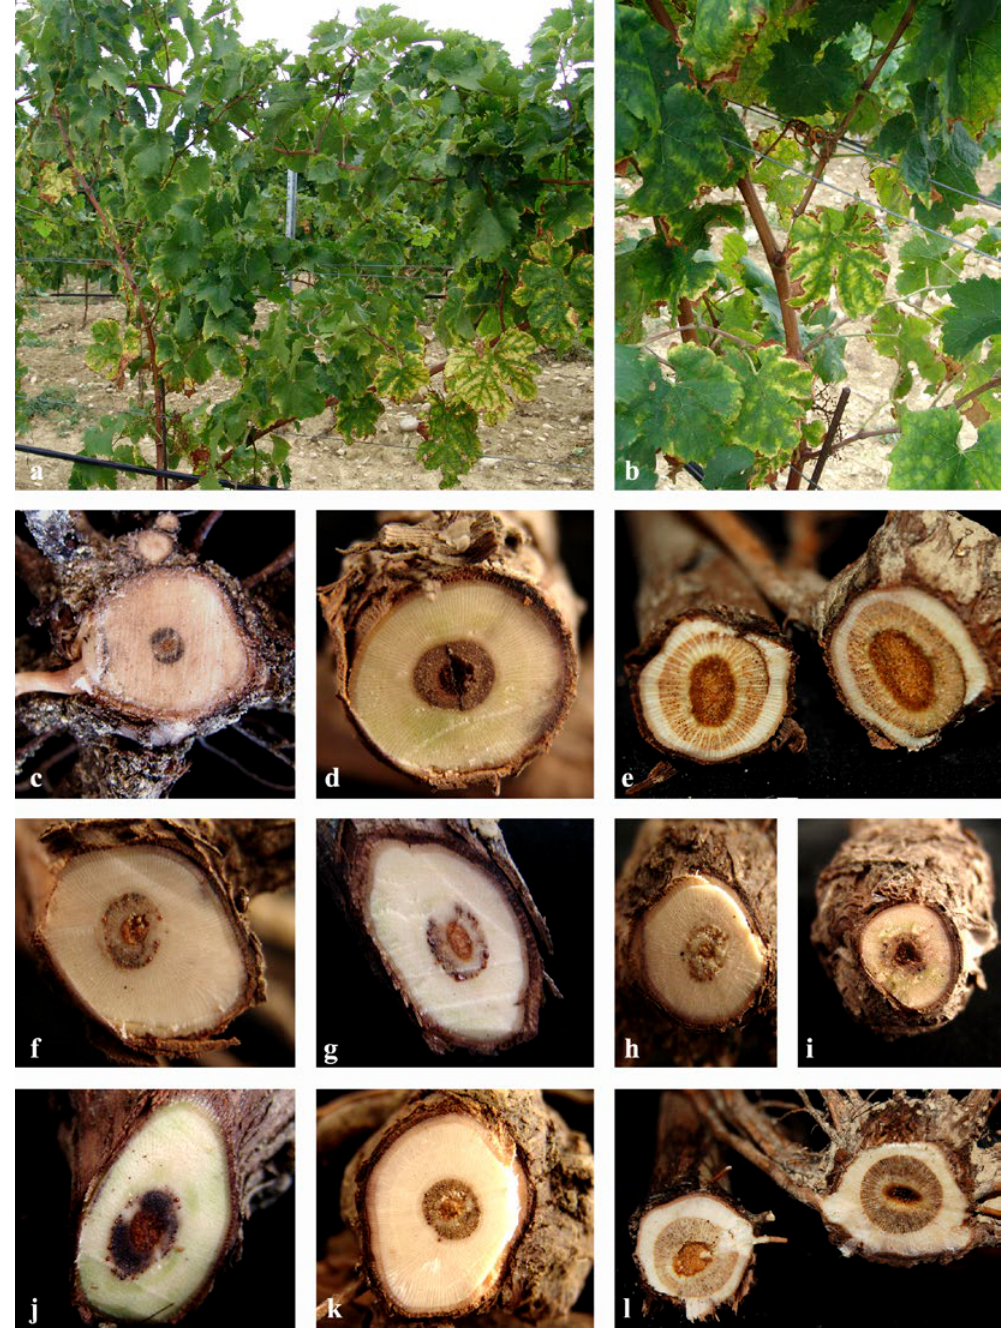
Figure 1. (a-b) Young grapevine showing discolouration of leaf similar to that associated with PD (Petri disease). (c-e) Black and brown wood discolouration in cross-section from which BFD (black foot disease) fungi ( Dactylonectria spp., Ilyonectria spp. and Thelonectria sp. nov.) were mainly isolated. (f-i) Brown wood discolouration and black exudate drops in cross- section of young grapevine and rootstock from which PD and BFD fungi were mainly isolated. (j-l) Black and brown dis- colouration, black exudate drops, and browning streaks in cross-section of young grapevine and nursery rootstock plants from which PD, BD (Botryosphaeria dieback) and BFD fungi were